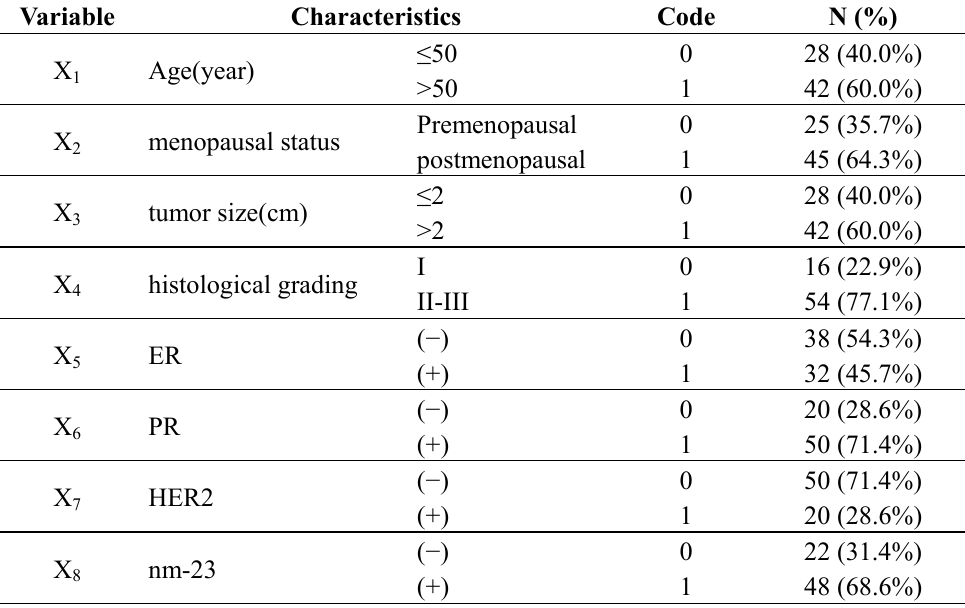
Table 1. Patients and tumor characteristics (n =